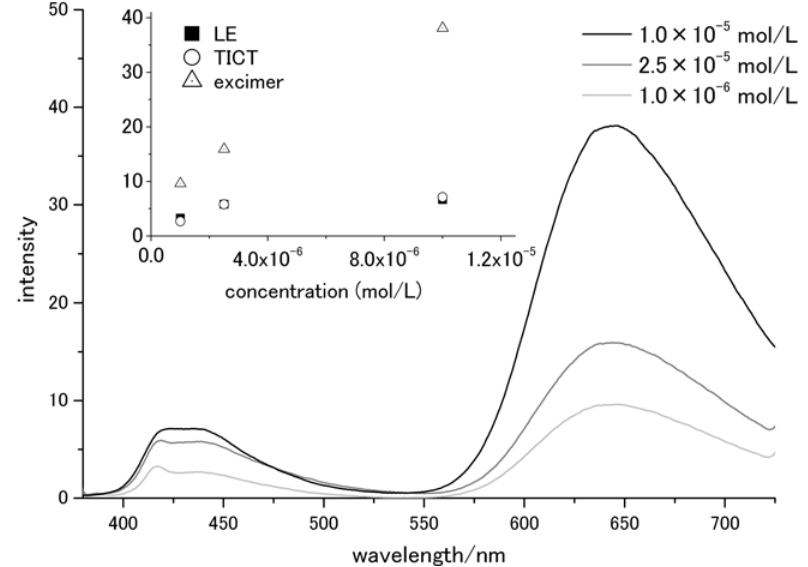
Figure 2. Concentration dependence of fluorescence spectra in THF at 370 nm excitation.